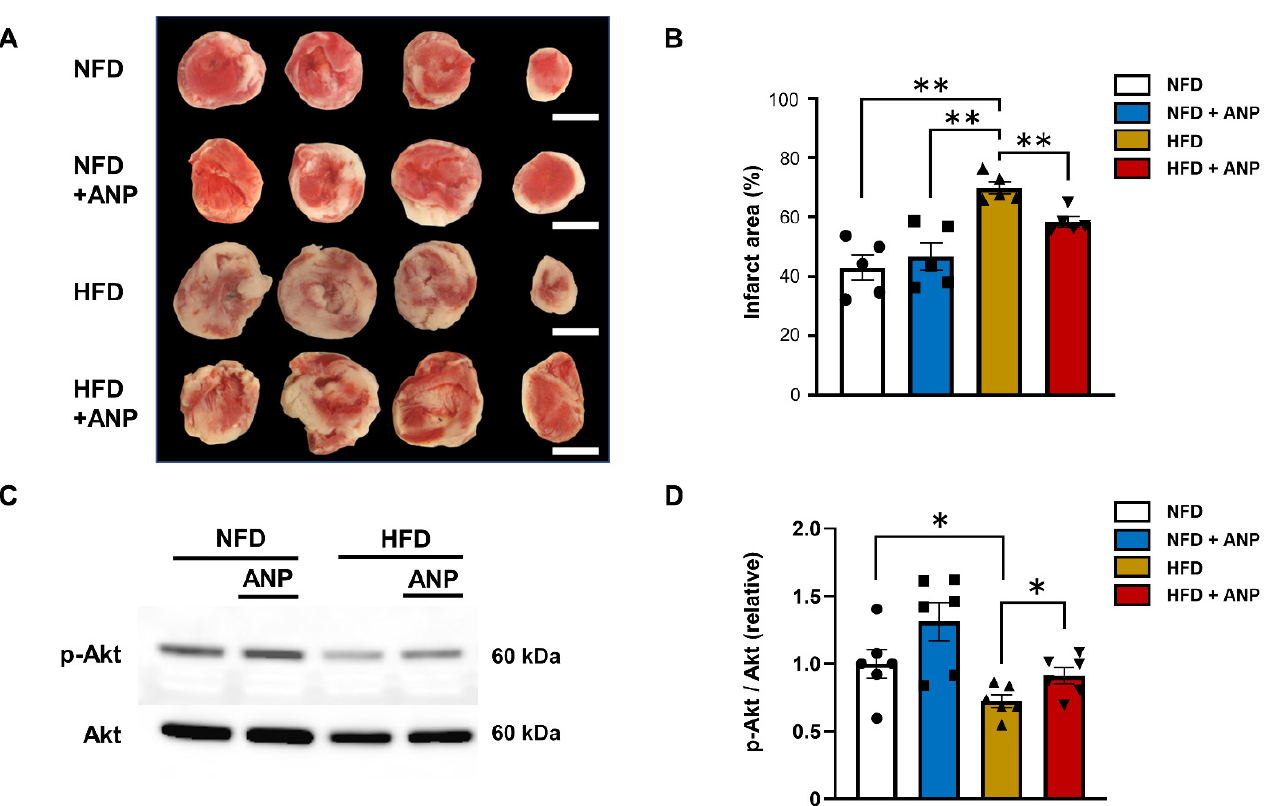
Figure 4. ANP treatment improved IRI and insulin sensitivity in HFD hearts. ( A ) Micrograph showing representative triphenyltetrazolium chloride (TTC) staining of cardiac sections obtained from NFD, NFD+ANP, HFD, and HFD+ANP groups after ischemia–reperfusion. Bars = 3 mm. ( B ) Effects on the quantitated cumulative infarct area size in NFD, NFD+ANP, HFD, and HFD+ANP hearts (n = 5 each). ( C ) Representative immunoblots for phospho- and total Akt from cardiac lysates after ischemia–reperfusion. ( D ) Densitometric quantitation normalized to the level of p-Akt/total Akt expression in NFD hearts after IRI is shown (n = 6 each). * p < 0.05 and ** p < 0.01 versus HFD.